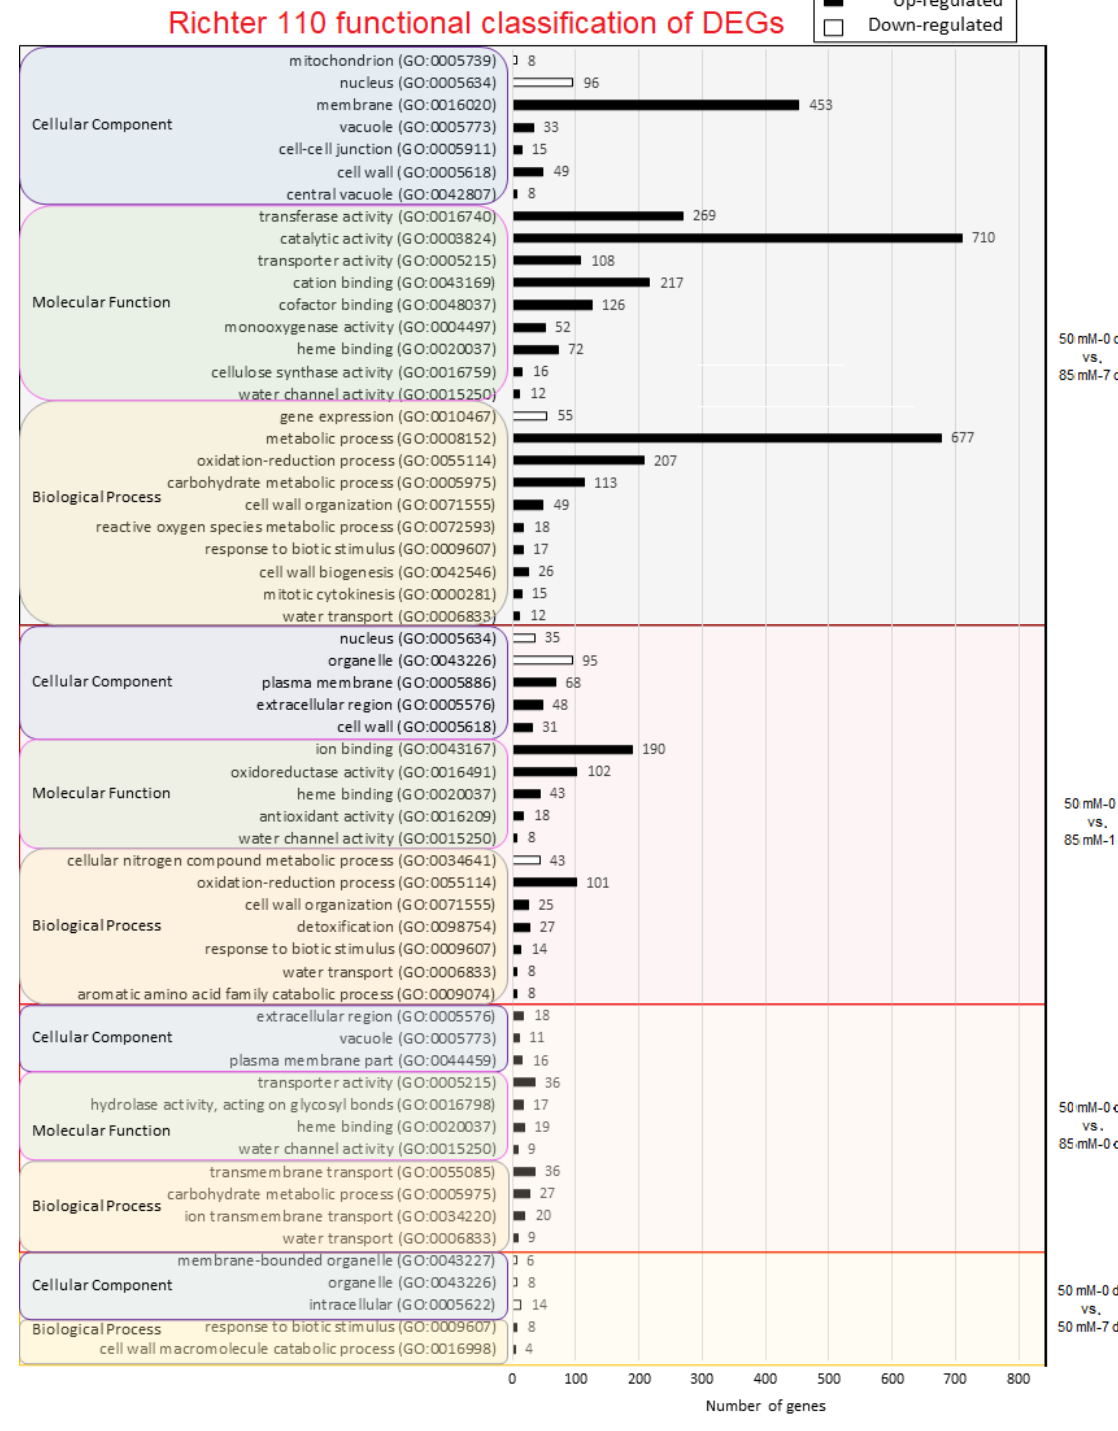
Figure 4. Panther output of GO results obtained in DEG analysis in Richter 110 under different comparisons: Control vs. 50 mM-0 d (green region), 50 mM-0 d vs. 50 mM-1 d (brown region), 50 mM-0 d vs. 50 mM-7 d (yellow region), 50 mM-0 d vs. 85 mM-0 d (red region), and 50 mM-0 d vs. 85 mM-7 d (gray region). Number of GO detected are expressed in upregulated (black bars) and downregulated (white bars) GO functions. For each comparison, 3 GO levels are shown: biological process (gray-outlined yellow box), molecular function (pink-outlined green box), and cellular component (violet-outlined gray box).